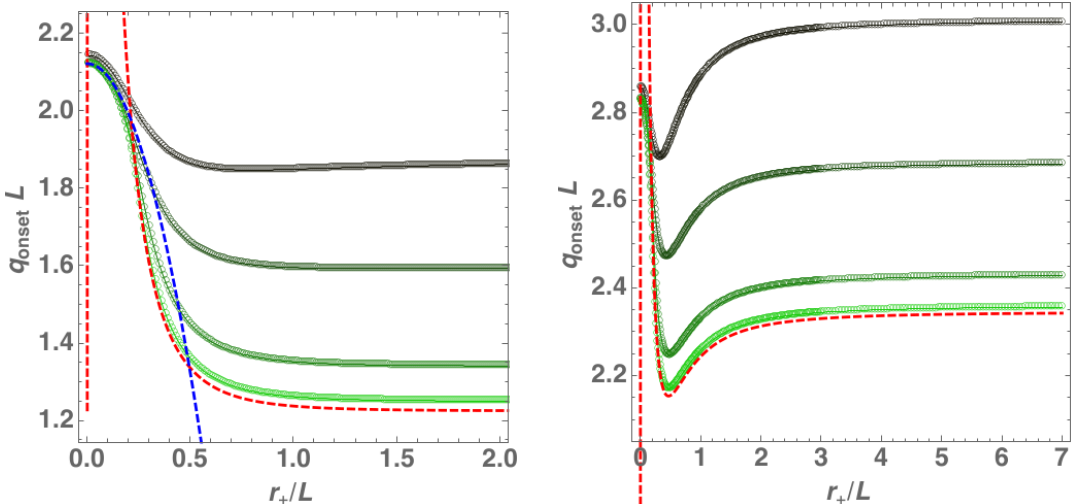
Figure 1 . Onset scalar (cid:12)eld charge as a function of the horizon radius for chemical potential (cid:22) = (cid:22) ext (1 (cid:0) 10 (cid:0) x ) with x = 2 ; 3 ; 6 ; 15 (from top to bottom on the right of each panel). The left panel corresponds to massless scalar (cid:12)elds; the right panel to massive scalar (cid:12)elds with mL = 2. The red dashed line is the near-horizon condensation analytic bound (3.7). In addition in the left panel we have the dashed blue line (for small horizon radius) which is the superradiant bound (3.8). regions, the superradiant and near-horizon instabilities are entangled. These features are not unique to the massless case. For example, the onset charge plot for a scalar mass of mL = 2 is shown in the right panel of (cid:12)gure 1. Again, as extremality is